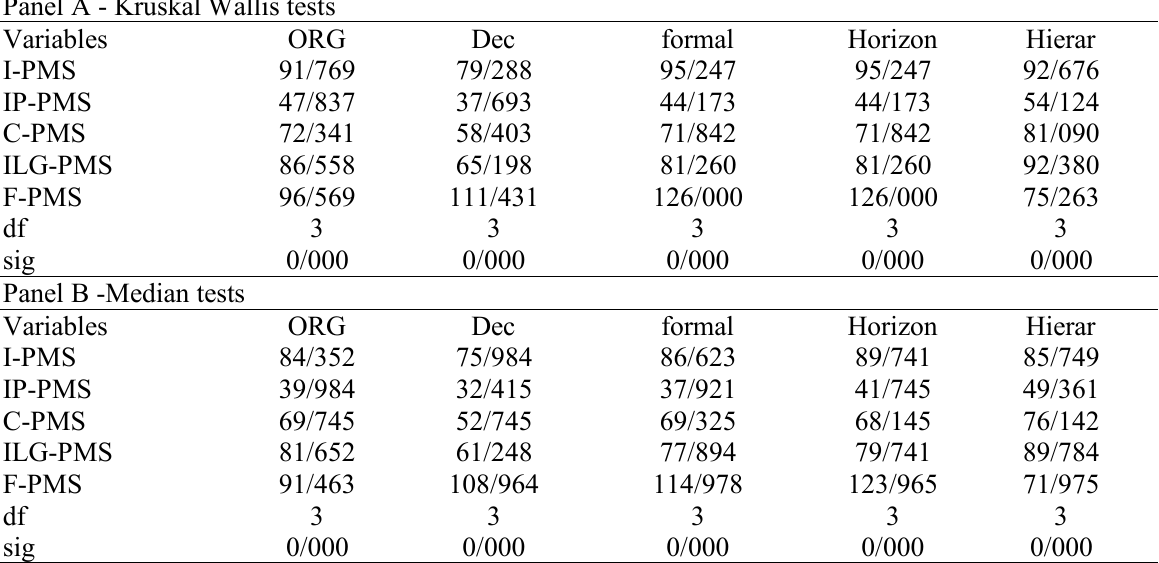
Table 6 . Chi-square Values of Comparative tests(N= 127) Panel A - Kruskal Wallis